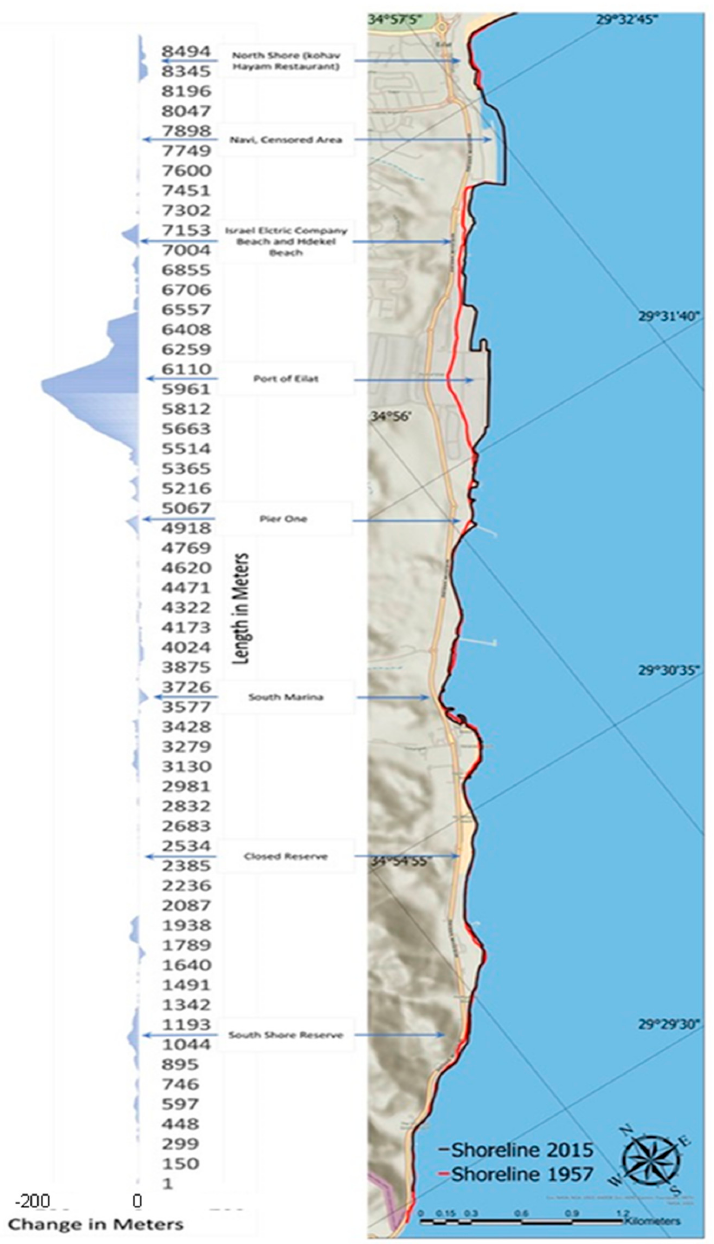
Figure 7. Changes in the morphology of the Israeli shoreline of the Gulf of Aqaba over six decades. Right panel: the shoreline, defined as the border between water and land, as delineated based on the 1957 (red line) and 2015 (black line) images. Left panel: distance, in meters, between the two shorelines, with negative values indicating expansion of land towards the sea.